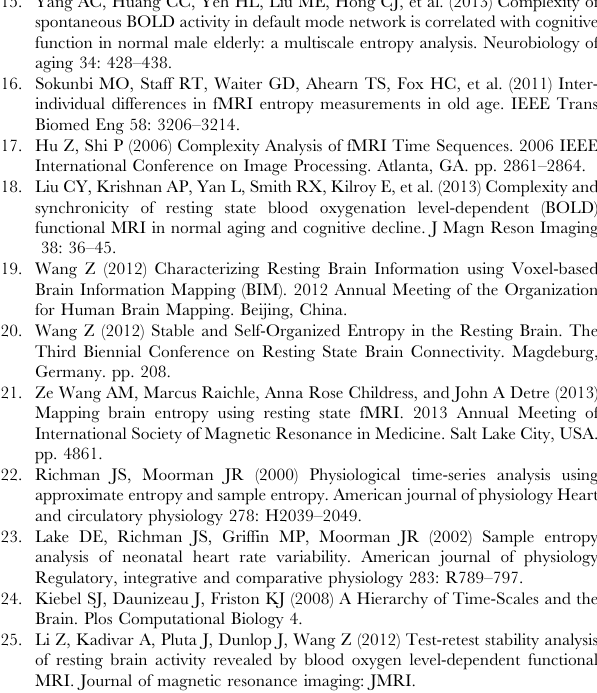
Figure S5 Two different data subsets-based BEN clus- tering results. A) Eight brain subdivisions identified from the 525 randomly selected subjects’ rBEN maps, B) eight brain subdivisions the rest 524 subjects’ rBEN maps using the data- driven spectral clustering method. These clusters were identified at the optimal peak of the curves shown in Fig. S4 using the same spectral clustering procedure as described in the main article. (DOCX) Figure S6 A) six brain subdivisions and B) fourteen brain subdivisions derived from 1049 subjects’ rBEN maps. These clusters were identified using the same spectral clustering procedure as described in the main article. The prior specified cluster number k of 6 and 14were located in the two suboptimal peak locations adjacent to the optimal one k = 8 as shown in Fig. S4. Table S1 Signal detection results using sample entropy and reference guided data fitting. Synthetic data were generated by adding noise to a boxcar function with 8 different level of contrast-to-noise-ratio (CNR). SampEn was calculated using an embedded dimension of 4, and 5 different tolerance levels. cc means Pearson’s correlation